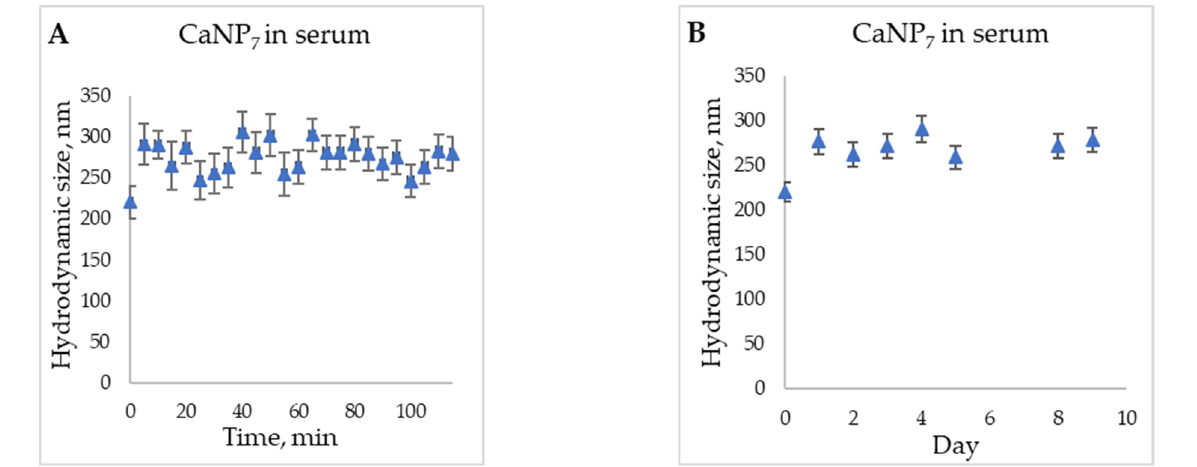
Figure 7 . Stability of CaNP 7 in 50% serum ( FBS) according to DLS data during the first hours ( A ); within 10 days ( B ). Figure 7. Stability of CaNP 7 in 50% serum (FBS) according to DLS data during the first hours ( A ); within 10 days ( B